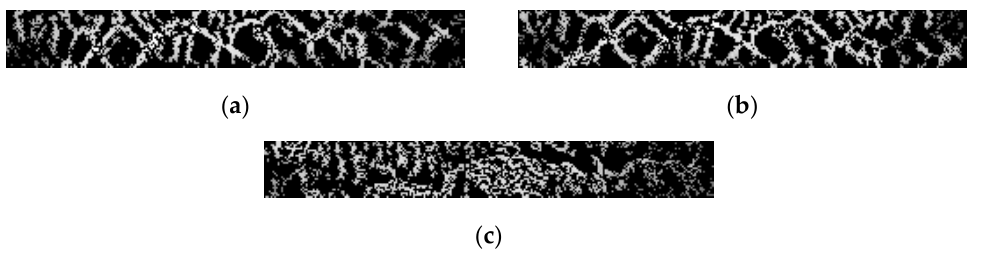
Figure 8. Six feature difference images: ( a ) Gaussian filter; ( b ) Square filter; ( c ) Median filter; ( d ) Bilateral filter; ( e ) Equalization histogram; ( f ) Laplacian of Gaussian.